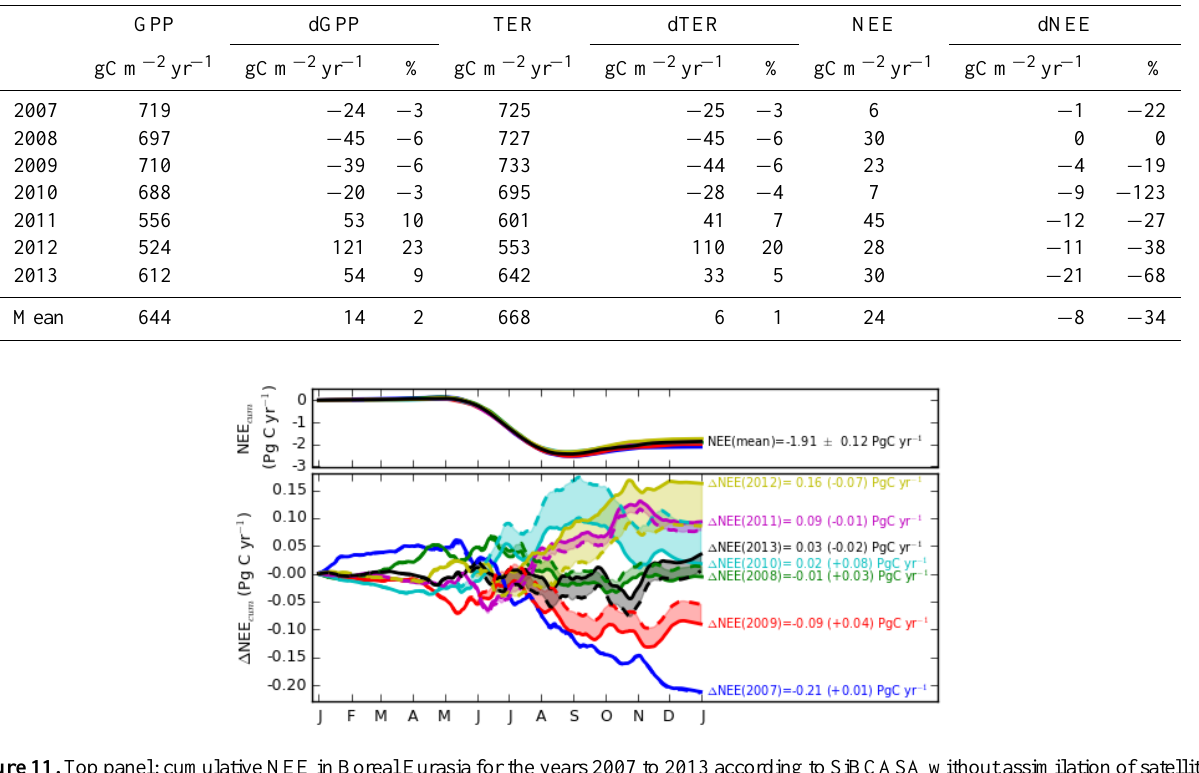
Figure 11. Top panel: cumulative NEE in Boreal Eurasia for the years 2007 to 2013 according to SiBCASA without assimilation of satellite- observed soil moisture. The text describes the 7-year mean NEE and the inter-annual variation (as standard deviation). Bottom panel: cumu- lative NEE anomaly relative to the 7-year mean. Solid lines represent the SiBCASA NEE anomaly ( (cid:49) NEE) without assimilation of ASCAT soil moisture, dashed lines represent the NEE anomaly with assimilation of ASCAT soil moisture. The text behind the lines describes the NEE anomaly relative to the inter-annual mean NEE and in parentheses the change caused by assimilation of ASCAT soil